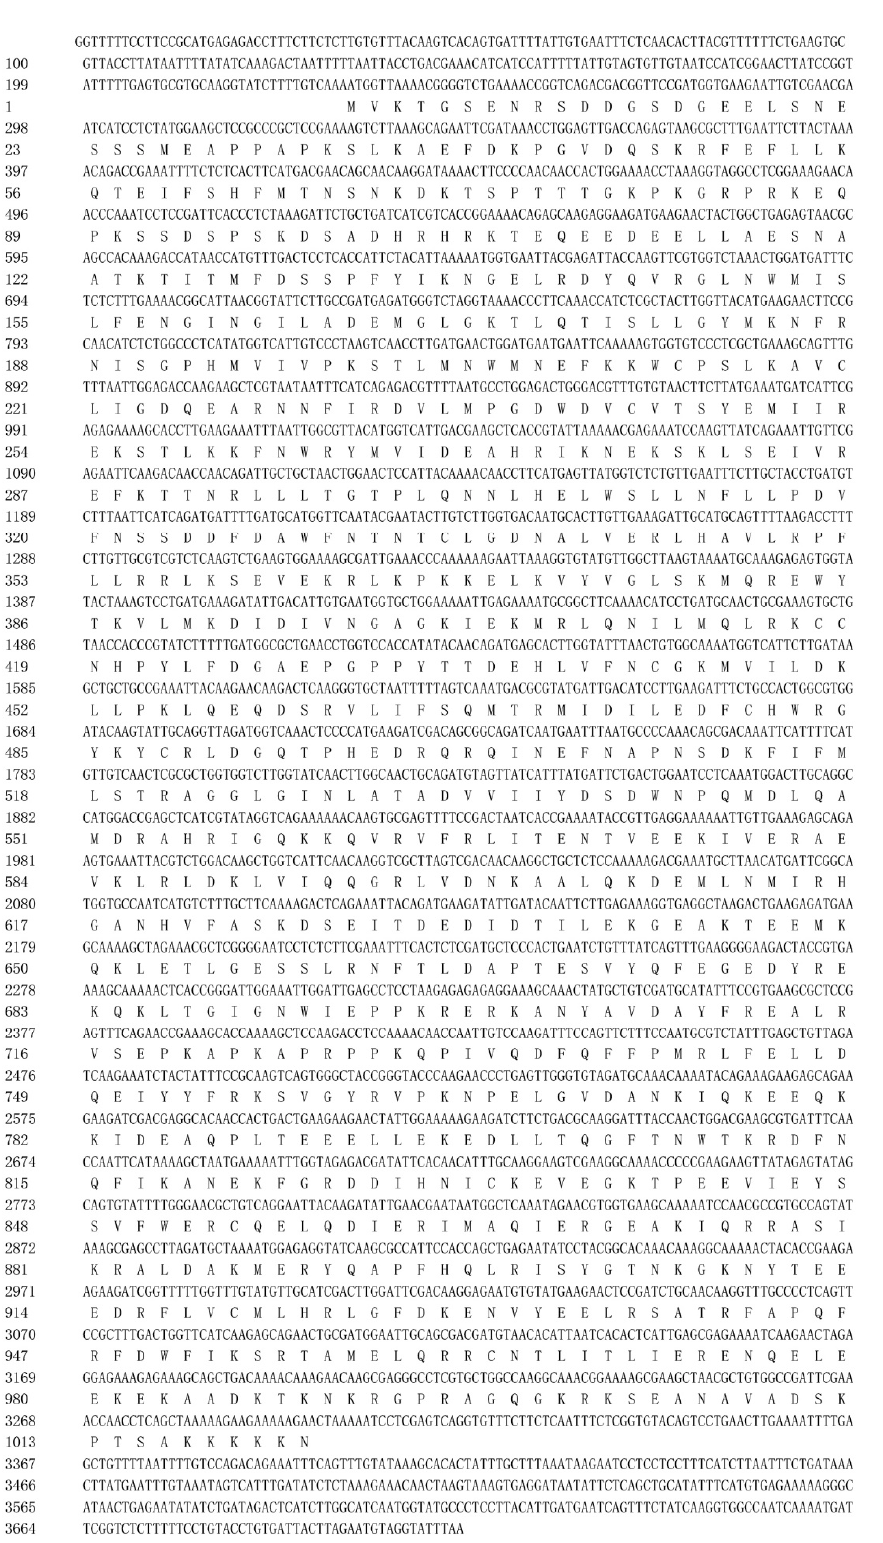
Figure 1. This The full-length cDNA sequence of Bemisia tabaci MEAM1 BtISWI and its deduced amino acid sequence. The full-length cDNA of MEAM1 BtISWI is 3712 bp, and the ORF (233–3301 bp) encodes a polypeptide of 1022 amino